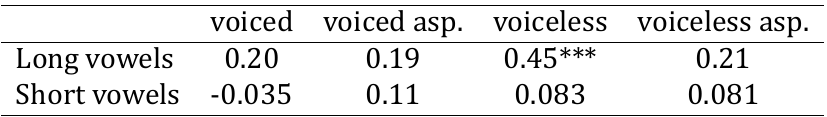
Table 9: Correlations between Telugu vowel duration and stop closure duration. N was approximately 64 in each group, with some variation due to errors and unreleased stops.